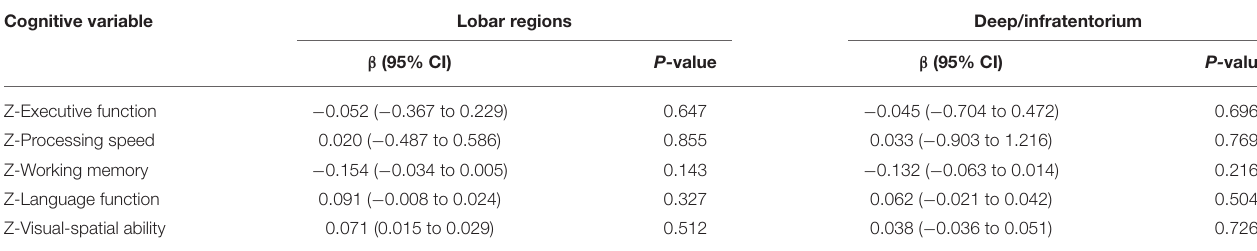
TABLE 4 | Multiple linear regression analysis in the T2DM group (number of CMBs).